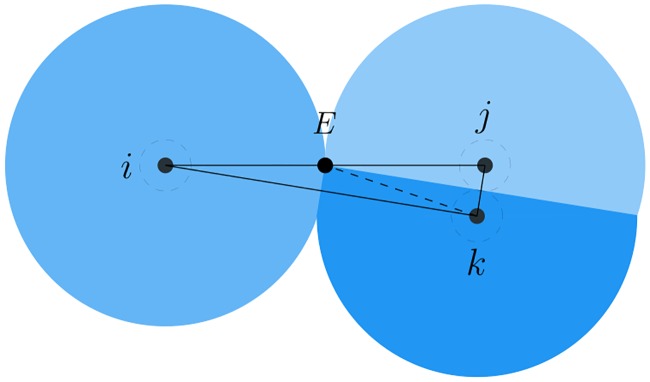
The worst case of link deletion.The critical configuration used to determine the upper bound of the hysteresis in link addition.